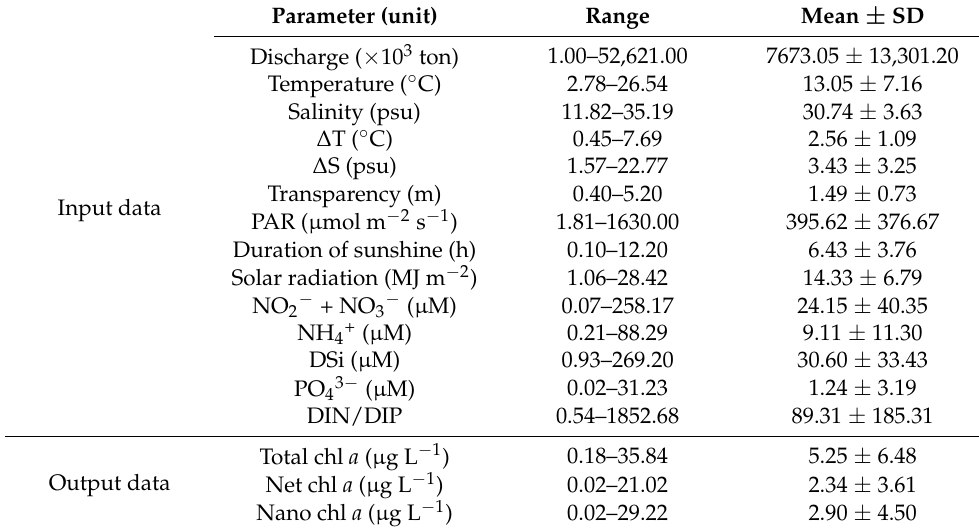
Table 1. Range and mean (standard deviation) of input and output data used in the artificial neural network model.